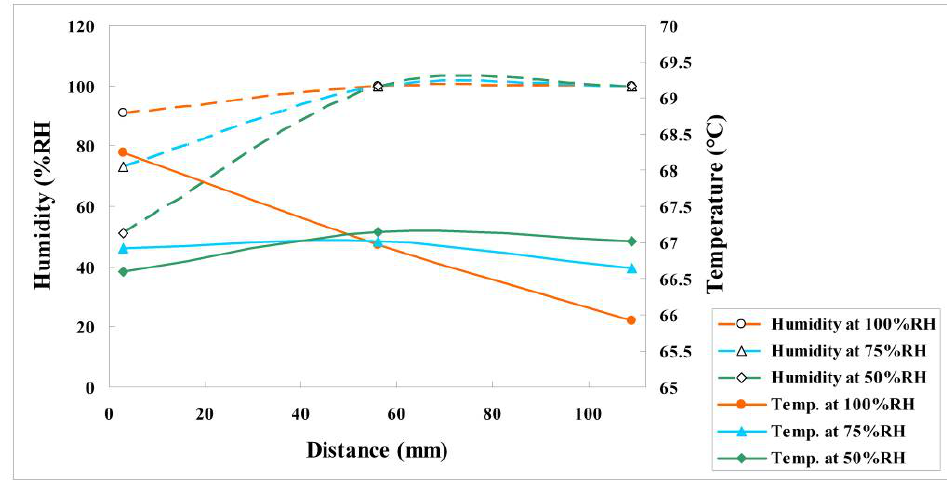
Figure 19. Variation of temperature and humidity at upstream, midstream and downstream (1 A/cm 2